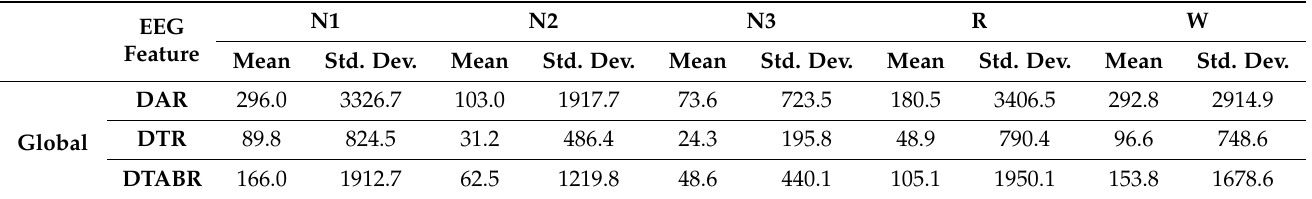
Table 3. Statistical results (Mean and Standard Deviation) of EEG Delta features (DAR, DTR, and DTABR) in the Global cortex during sleep stages W, N1, N2, N-3, and R. Global indicates the average measures of features of the frontal, central, and occipital